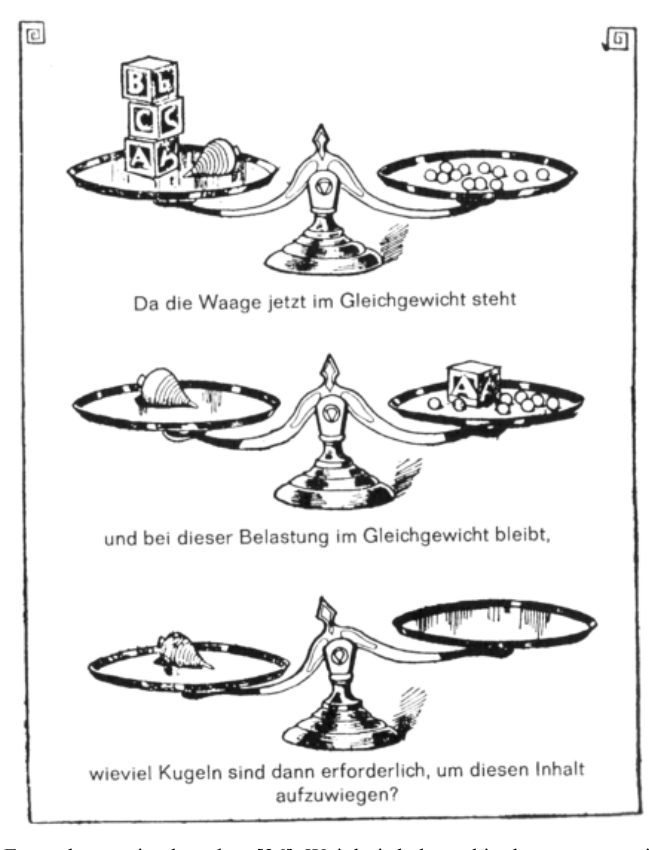
Fig. 2. Example question based on [26]. Weight is balanced in the upper two